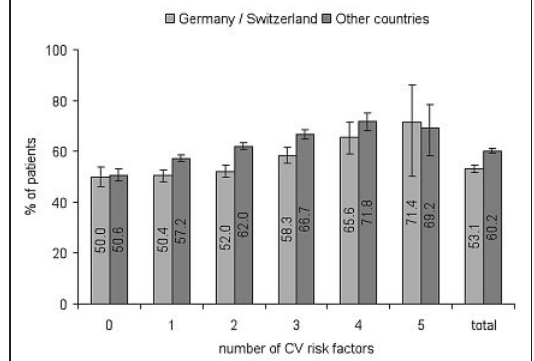
Figure 2 Mean prevalence estimates [95% CI]; the risk factors considered are: no regular exercise, current smoking, known dyslipidemia, family history of myocardial infarction or documented CAD and Diabetes.